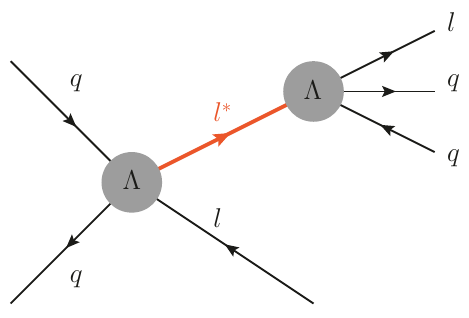
Figure 1 . Feynman diagram for the production of an excited lepton in association with an SM lepton in a hadron collider. The excited lepton decays via a contact interaction to one SM lepton and two resolved jets, which result from the hadronization of the